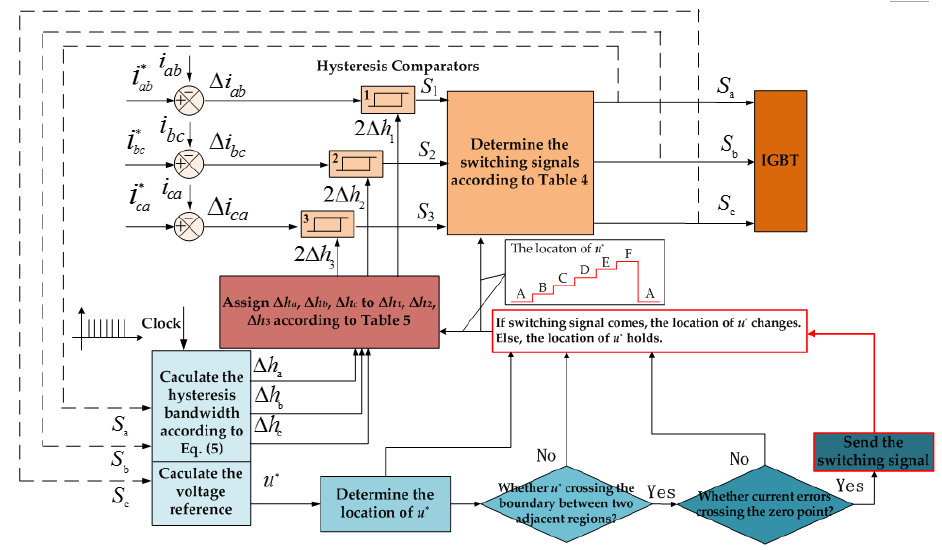
Figure 11. The overall smoothly transitive fixed frequency hysteresis current control (ST-FHCC) procedure.